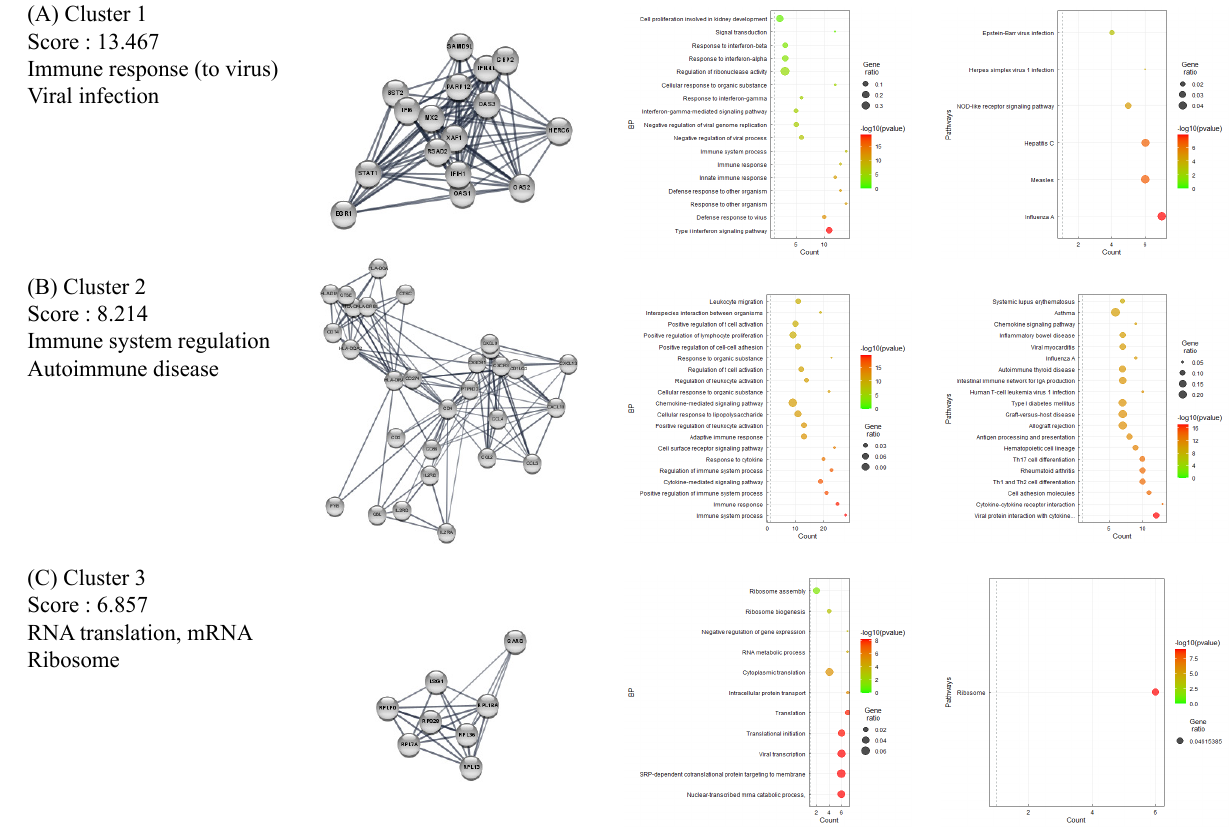
Figure 2. Functional clustering of upregulated DEGs in HT samples, using the MCODE algorithm. Results of BP and KEGG-enrichment analyses presented as dot plots. Each cluster represents a set of highly connected genes. ( A – C ) represent Clusters 1–3, respectively, which have the highest clustering